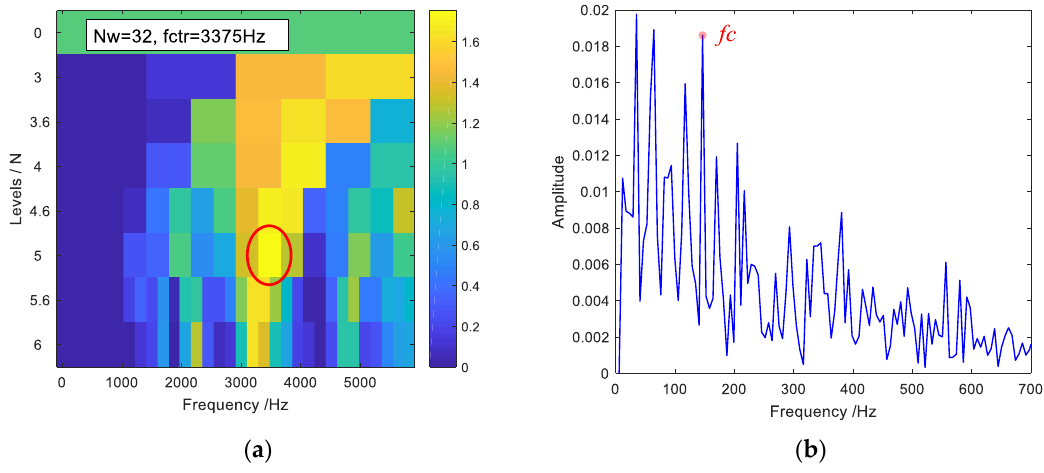
Figure 19. Results based on MSK in case 2: ( a ) Kurtogram of the signal; ( b ) envelope spectrum of the filtered signal.